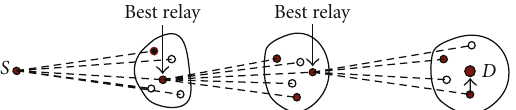
Figure 1: Principle of opportunistic routing in opportunistic